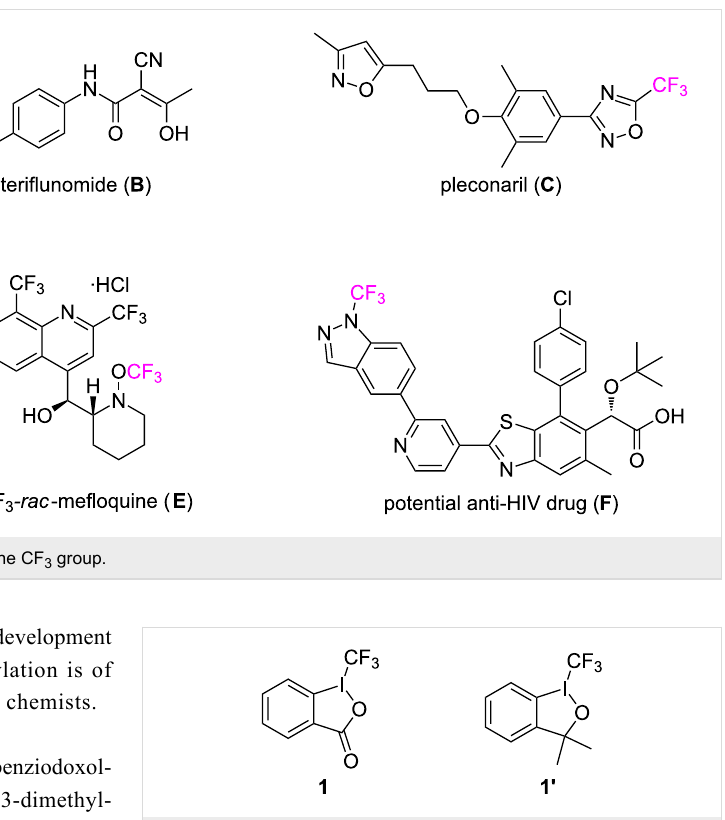
Figure 2: The structures of the Togni reagents 1-(trifluoromethyl)-1,2- benziodoxol-3(1 H )-one ( 1 ) and trifluoromethyl-1,3-dihydro-3,3- dimethyl-1,2-benziodoxole ( 1’